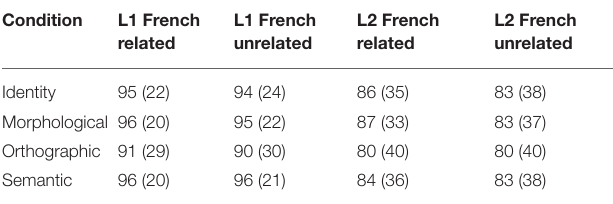
TABLE 4 | Lexical decision accuracy (SD) by condition and relatedness (percent). TABLE 5 | Mean reaction times (SD) and priming effects